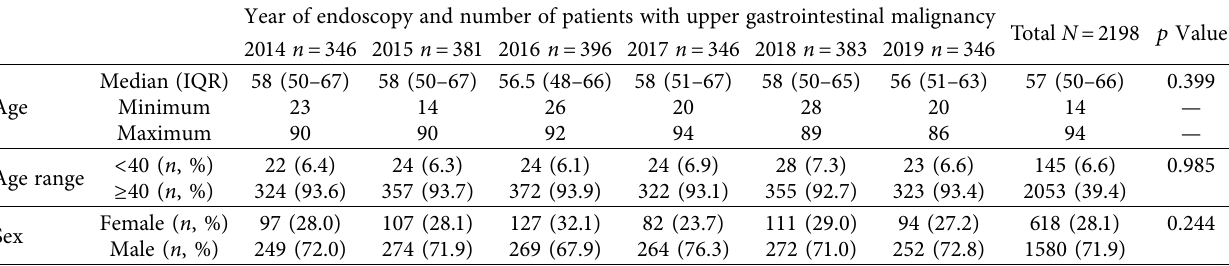
Table 2: Age and sex distribution of the patients with upper gastrointestinal malignancy during the 2014–2019 period.